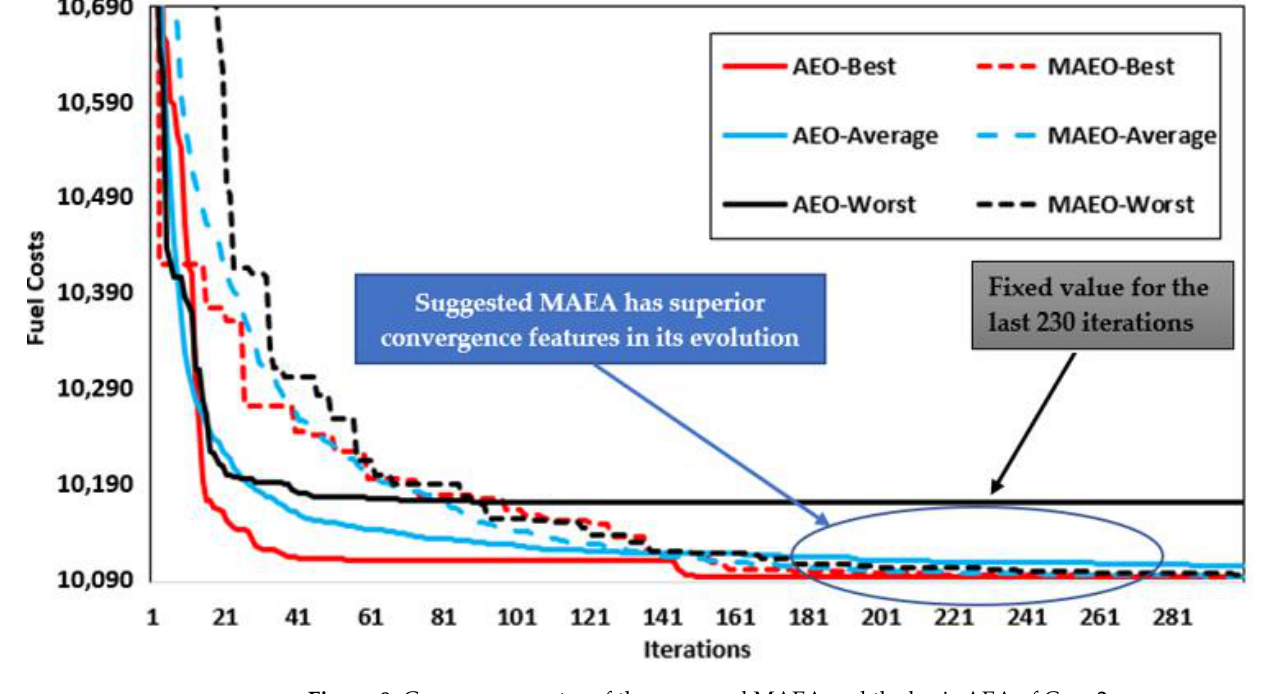
Figure 8. Convergence rates of the proposed MAEA and the basic AEA of Case 2.